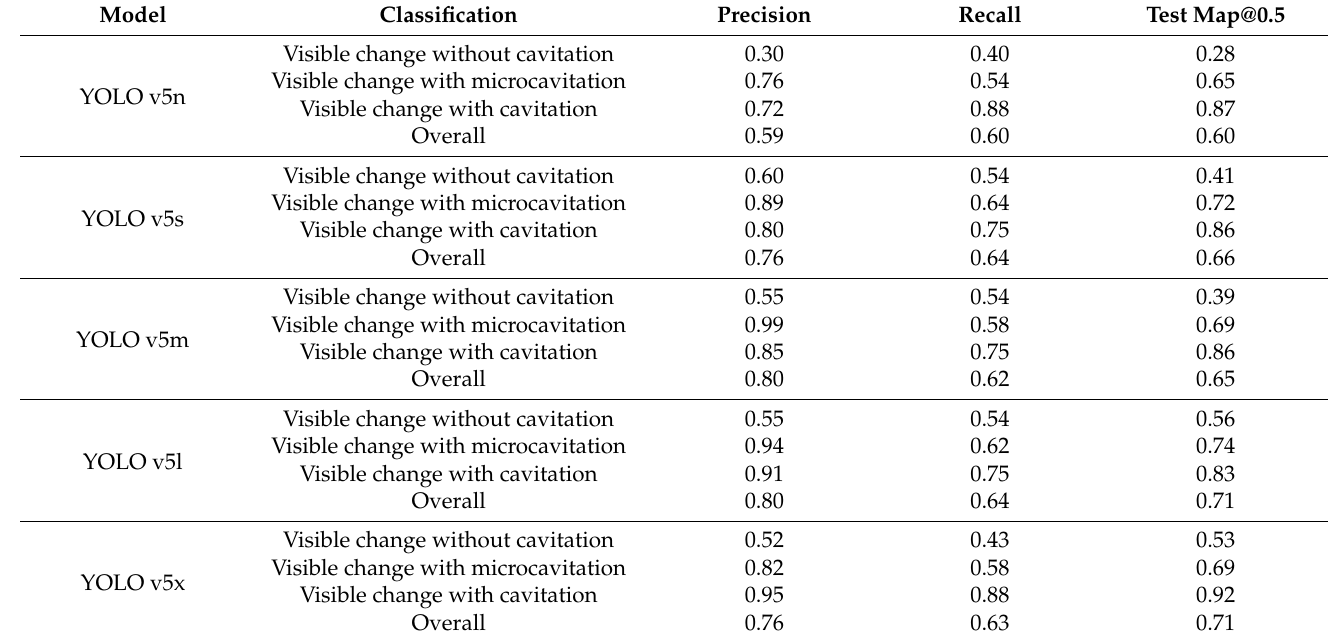
Table 1. Results obtained following model ensemble for YOLO network.